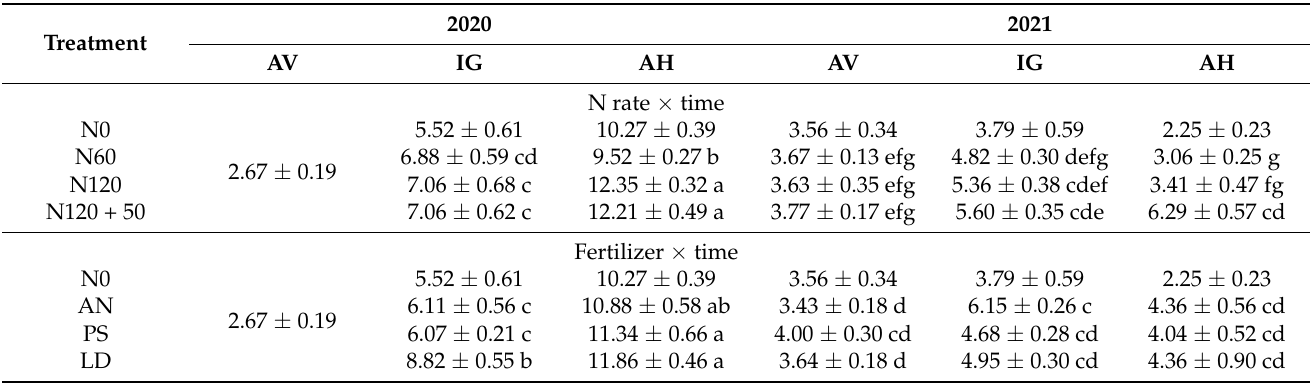
Table 3. Soil nitrate nitrogen (N-NO 3 ) variation during winter wheat growing season in mg · kg − 1 (0–60 cm).